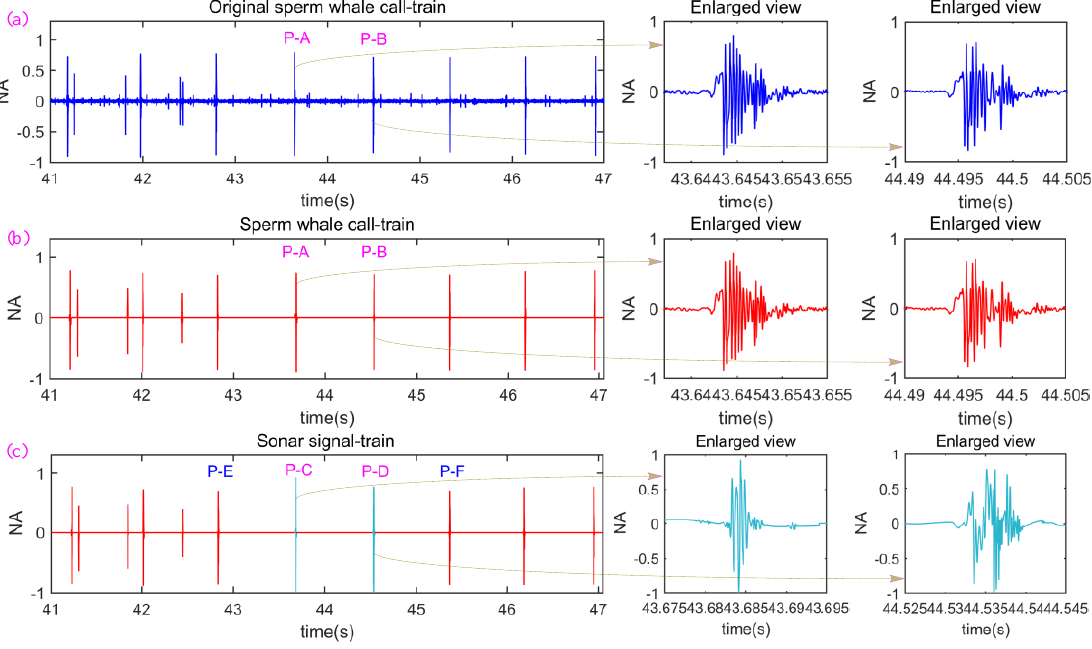
Figure 3. The constructed process of the disguised active sonar signal-train. ( a ) A part of the original sperm whale call-train from the 41st s to 47th s, where the ordinate is the normalized amplitude (NA) of call-train; ( b ) the sperm whale call-train after ocean noise is filtered out and low-energy call pulses are removed; ( c ) the constructed disguised active sonar signal-train.